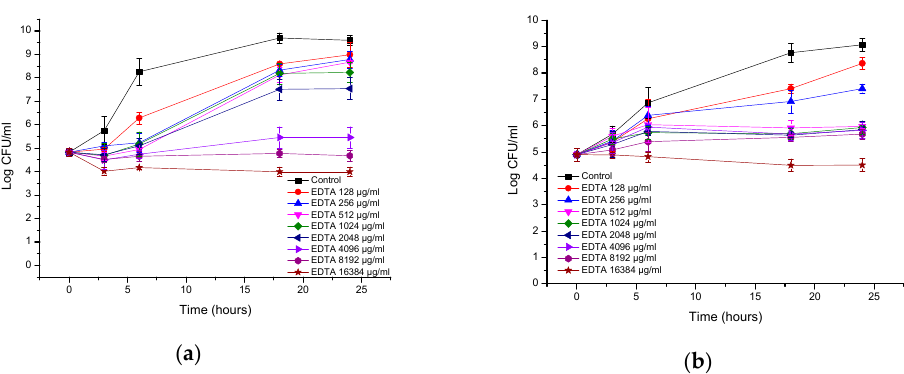
Figure 6. Time-kill curves of EDTA against ( a ) Pseudomonas aeruginosa ATCC; ( b ) Pseudomonas aeruginosa clinical isolate.